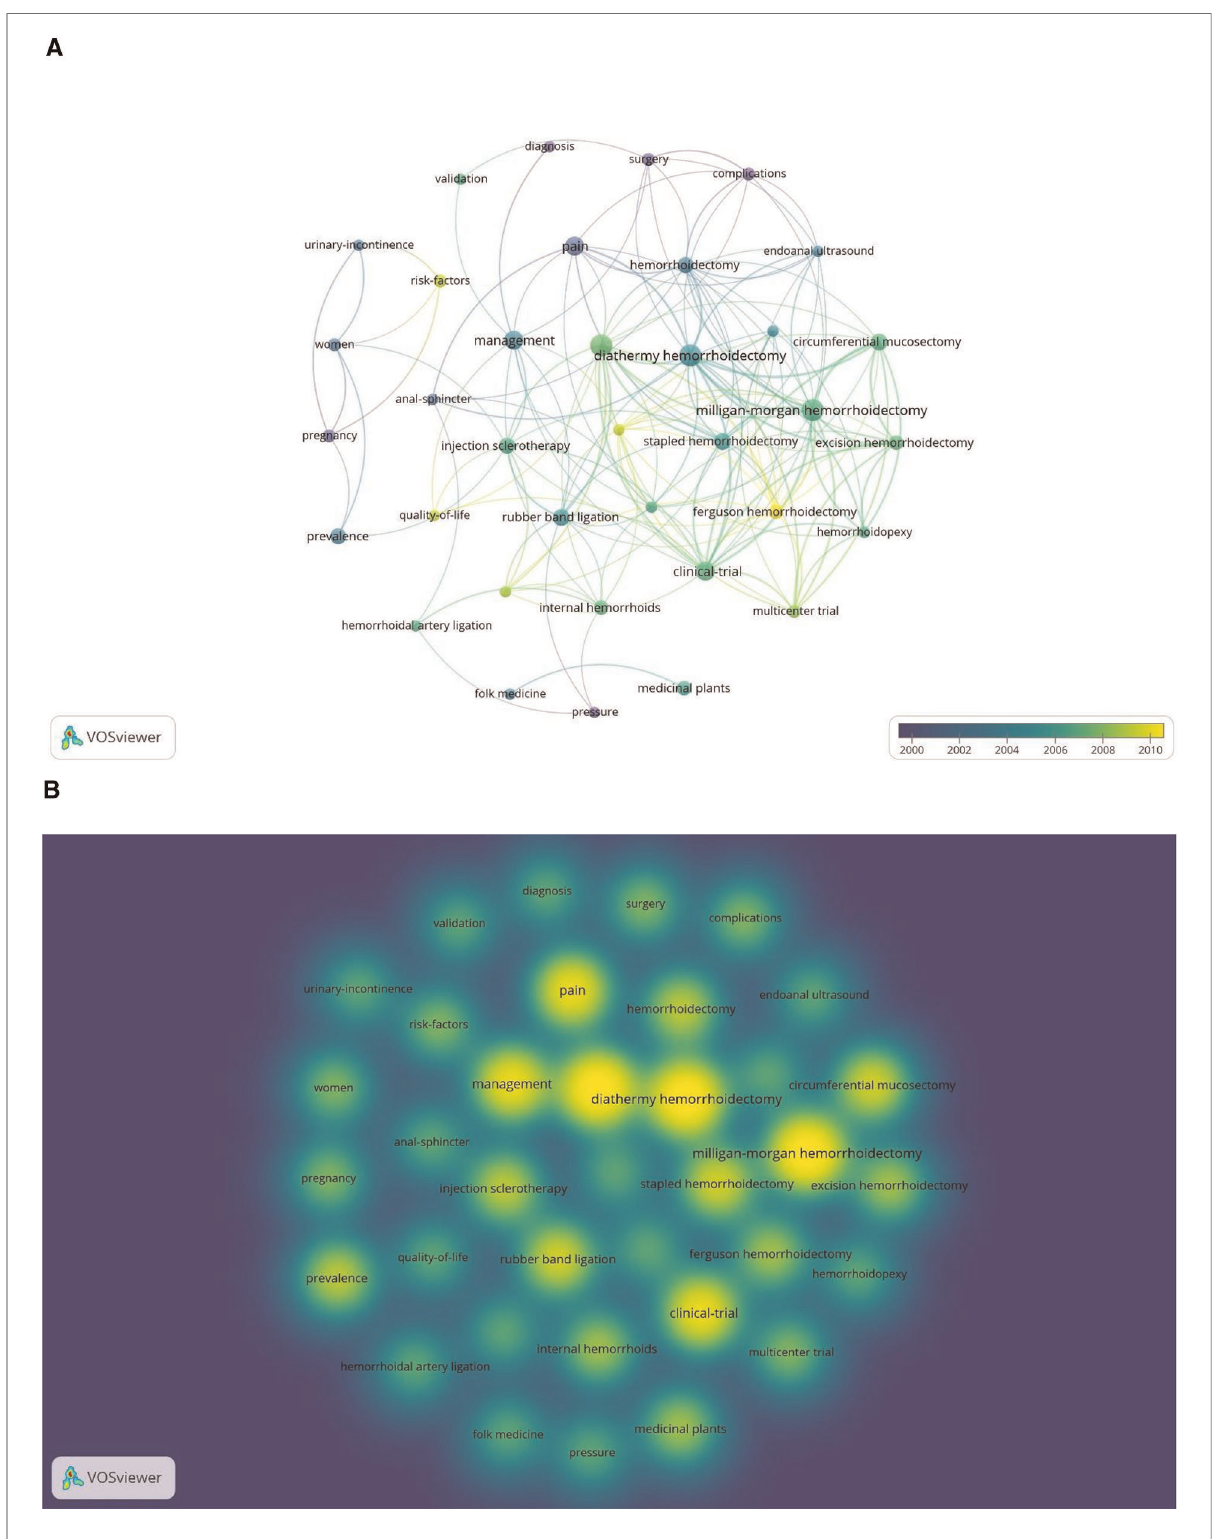
FIGURE 6 Network chart of keywords of the 100 most-cited articles. ( A ) Keyword co-occurrence chart, ( B ) Keyword heat diagram.